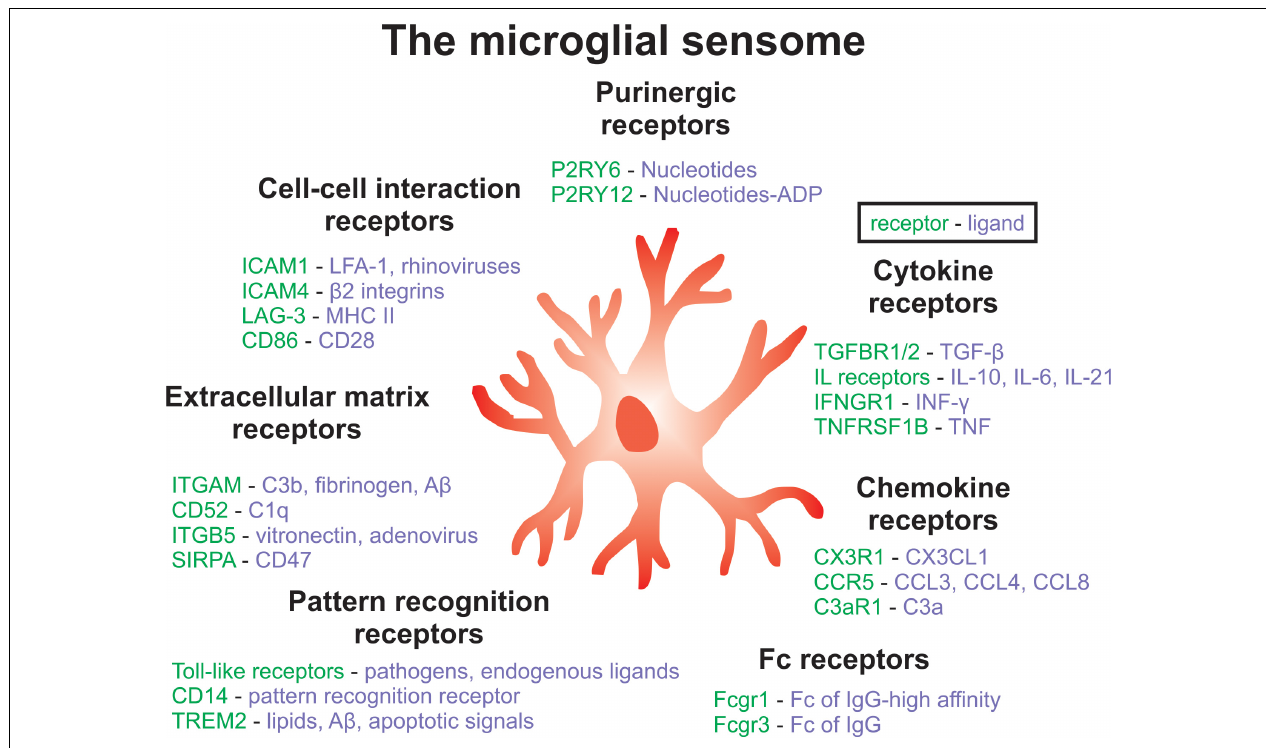
FIGURE 2 | Key components of the microglial sensome associated with SCZ. The microglial sensome is a group of receptors and proteins that allow microglia to sense and respond to their changing environment, facilitating the diverse roles of microglial as well as their complex interactions with multiple cell-types in the brain. Components of the microglia sensome can be categorized to include purinergic, cytokine, Fc, pattern recognition, extracellular matrix, and cell-cell interaction receptors and ligands, among others not listed here. Future work could aim at targeting the microglial sensome to normalize microglial function in